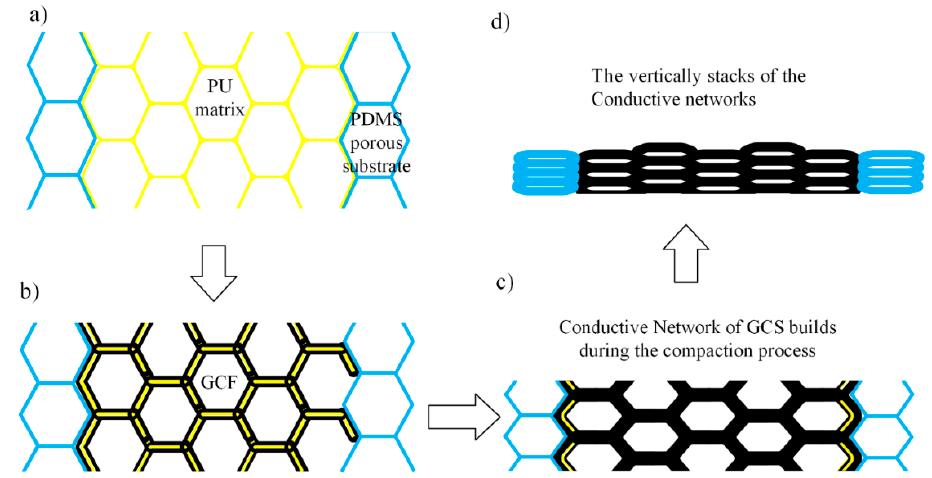
Figure 8. The piezo-resistive mechanism is in the composite: ( a ) interconnected network of the polyurethane (PU) matrix; ( b ) initial conductive paths are being built, owing to the graphene sheets coating; ( c ) the resistance of the conductive path has been enhanced, due to the increased density of graphene sheets; ( d ) the stacks of the conductive path until the compression limit.